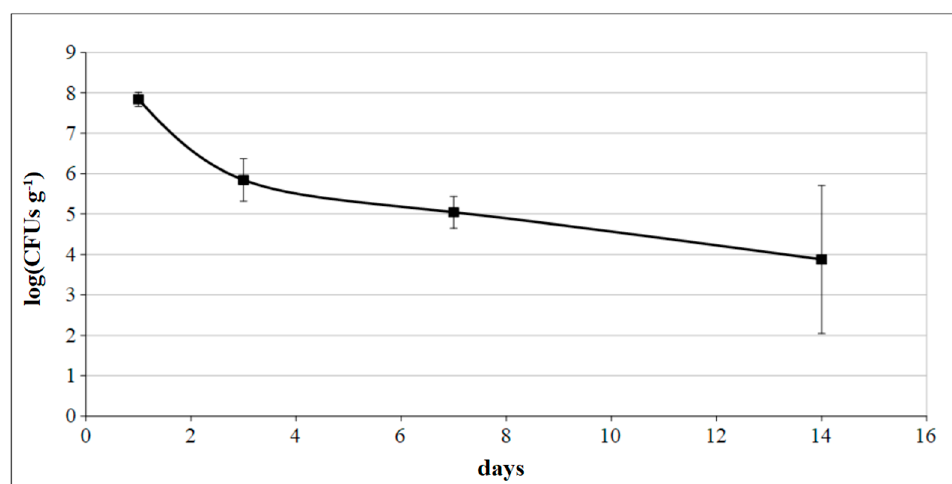
Figure 6. Leaves surface colonization of dsRed-tagged P. protegens MP12 strain after epiphytic inoculation performed by foliar spray.